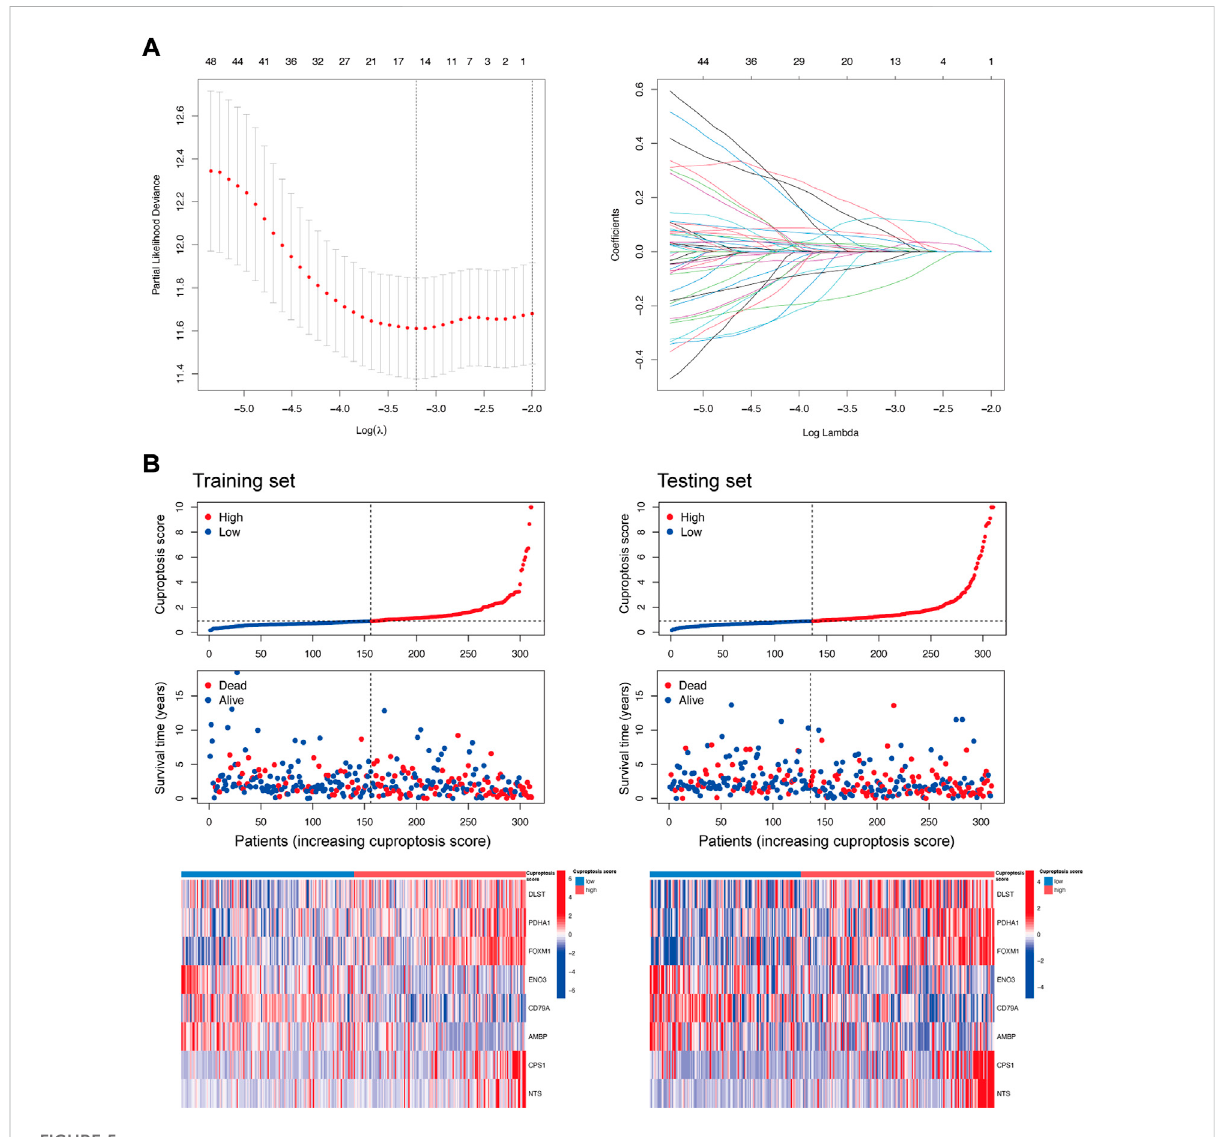
FIGURE 5 DEGs selection for the construction of the cuproptosis prognostic model. (A) Partial likelihood deviance and coef fi cients for LASSO. (B) Distribution of the cuproptosis score, survival status, and the expression of DEGs ( DLST, PDHA1, FOXM1, ENO3, CD79A, AMBP, CPS1, and NTS ) for modeling in the training set and testing